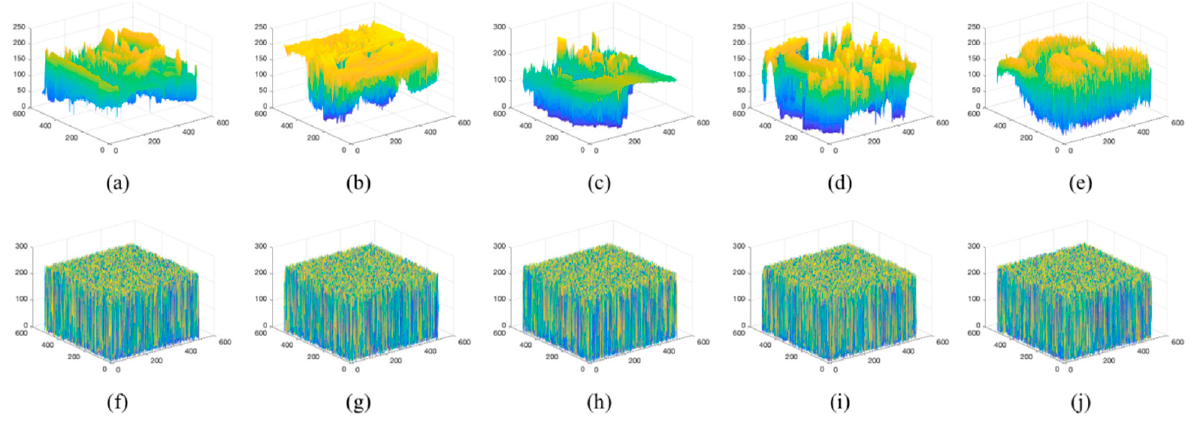
Figure 10. ( a – e ) 3D visualization of Lena, Airplane, Cameraman, Pepper and Baboon. ( f – j ) 3D visualization of encrypted images of Lena, Airplane, Cameraman, Pepper and visualization of encrypted images of Lena, Airplane, Cameraman, Pepper and Baboon.